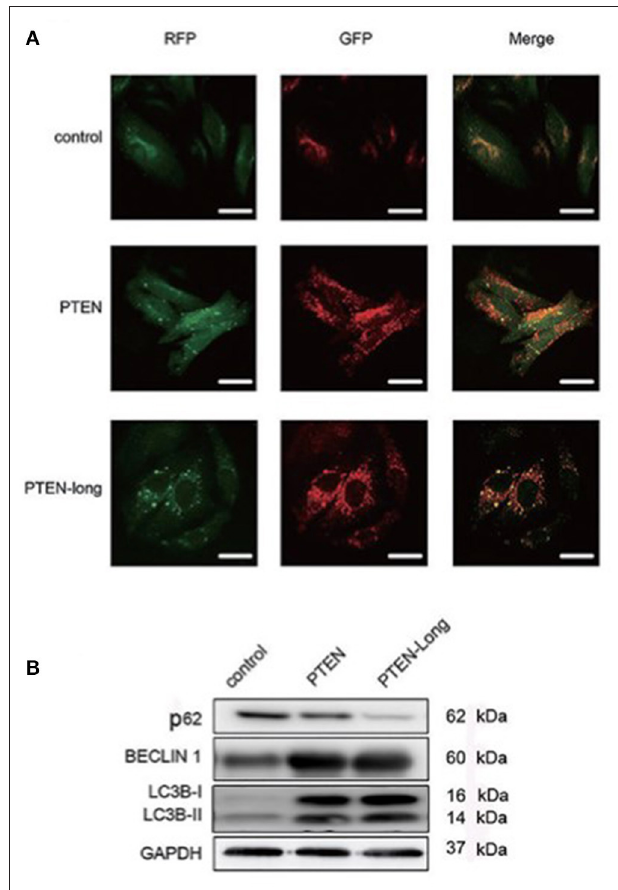
FIGURE 3 | PTEN-Long induces autophagy of HepG2 cells. (A) Autophagy analysis of cells ectopic-expressing PTEN or PTEN-Long. Scale bar = 20 µ m. (B) Western blot analysis of autophagy-related proteins in HepG2 cells.